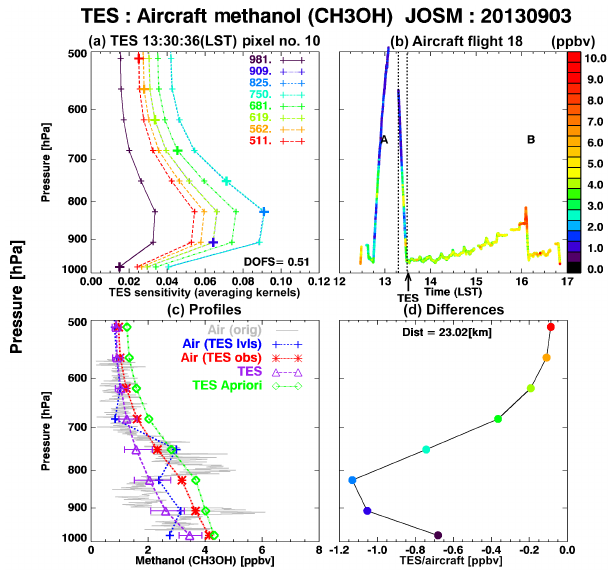
Figure 3. A representative aircraft/satellite comparison for a single CH 3 OH profile using the downward aircraft spiral from profile “A” with pixel 10 along the TES transect (counted from south to north). (a) contains the rows of the satellite averaging kernels at each re- trieval level. (b) shows the aircraft flight observations for the day as a function of altitude and local standard time (LST), with each aircraft “profile” (pair of the up or down profiles) indicated alpha- betically in measurement succession during the afternoon. The two dotted lines bound the observations selected to generate the com- parison aircraft profile. (c) shows the original aircraft (grey) pro- file, the aircraft profile mapped onto the TES retrieval levels (blue), and this same profile with the TES observation operator (Eq. 2) applied (red); this latter profile can be directly compared with the TES-retrieved profile (purple). The TES retrieval observation error estimates are also plotted as error bars. The TES a priori profile is provided in green. (d) contains the difference between the TES- retrieved profile (purple) and the aircraft profile (red) using the same colour scale as (a) for the retrieval altitude